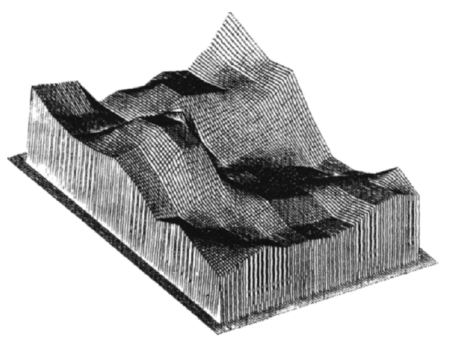
Figure 1. Example of an intensity pattern reconstructed using bilinear interpolation into a continuous form. Reproduced from Sutton et al. [1], with permission from Elsevier.